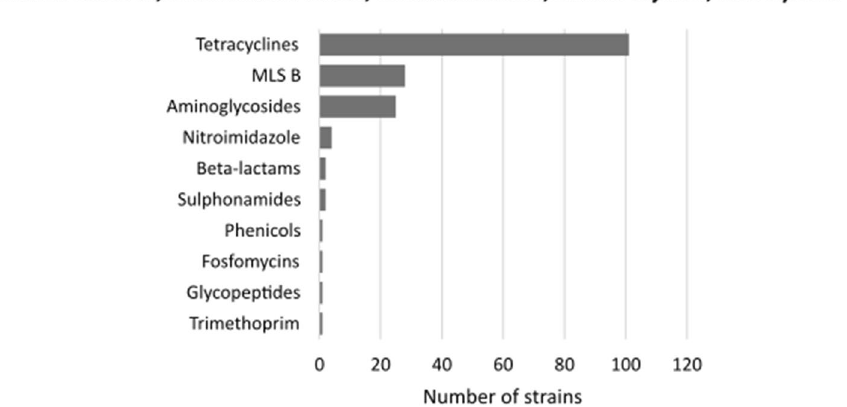
Figure 1. Acquired antibiotic resistance genes in chicken gut anaerobes. Whole genomic sequences of 259 gut anaerobes were searched using ResFinder for the presence of horizontally acquired genes responsible for antibiotic resistance. See Supplementary Fig. S1 for the distribution of these resistances among individual